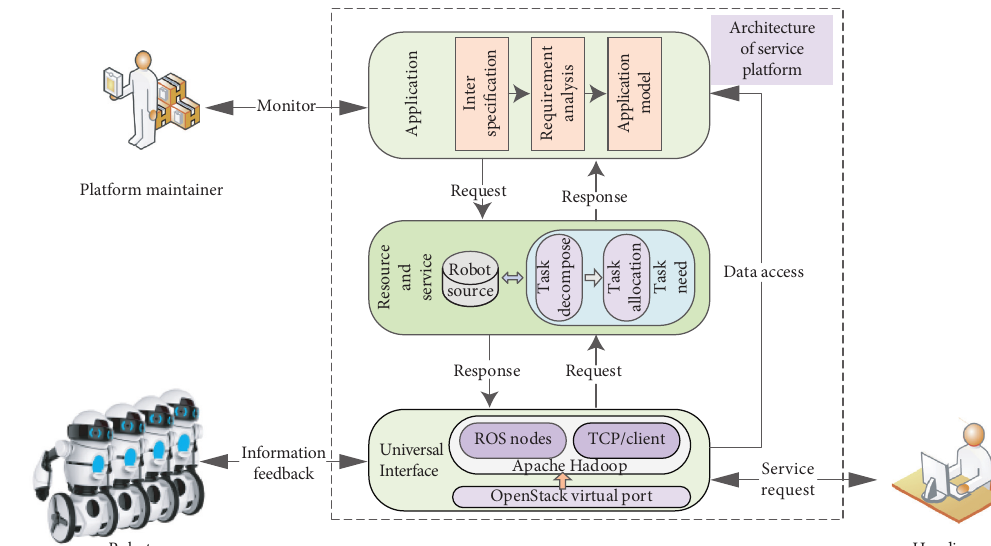
Figure 2: RSP-AHEP: robotics service platform for assisting handicapped or elderly people.